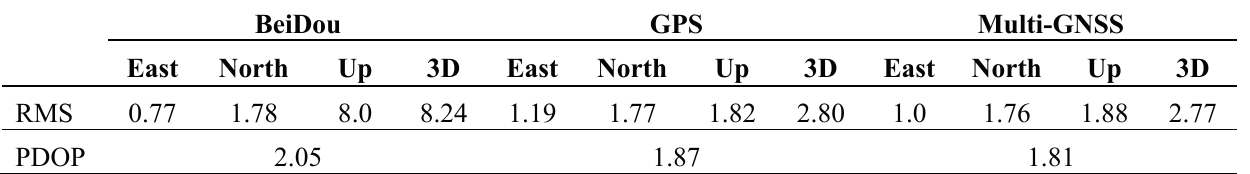
Table 3. Position error statistics with respect to true